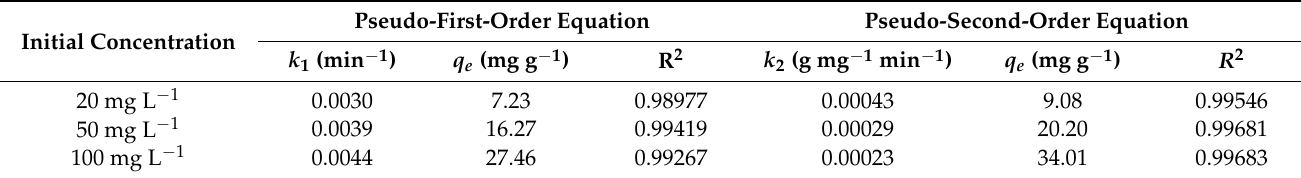
Table 4. Kinetic parameters of As(III) adsorption by the D-Mn gel.